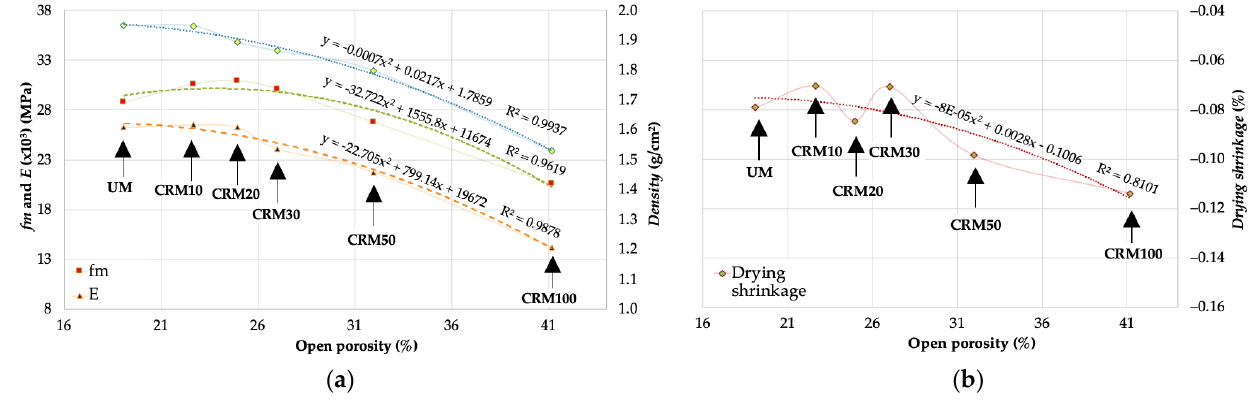
Figure 15. Correlation Open porosity and: ( a ) fm , E and density ; ( b ) drying shrinkage .